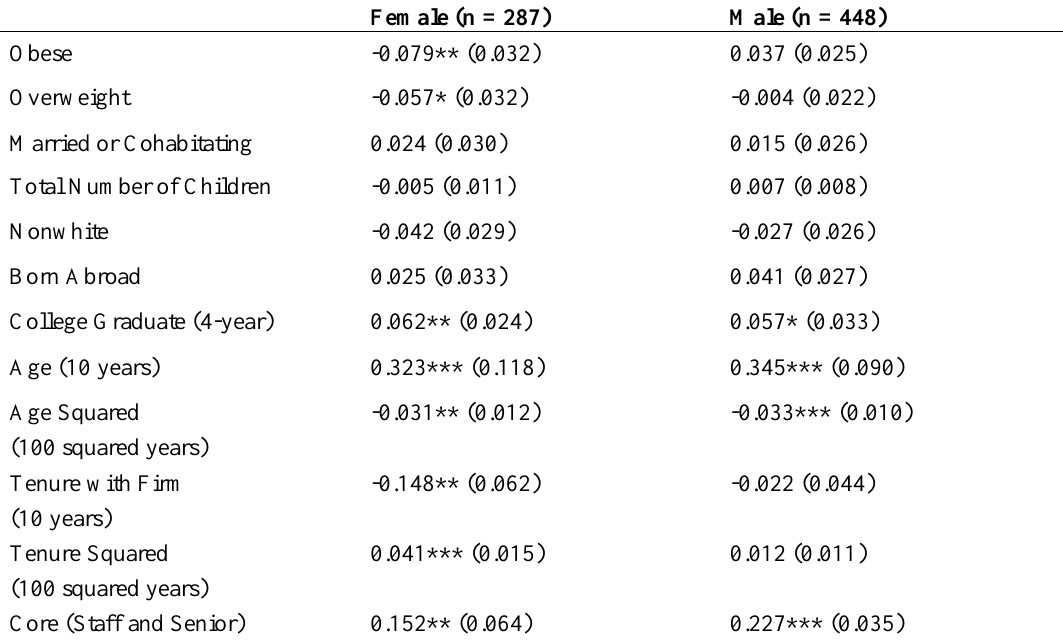
The relationship between wages and obesity with standard